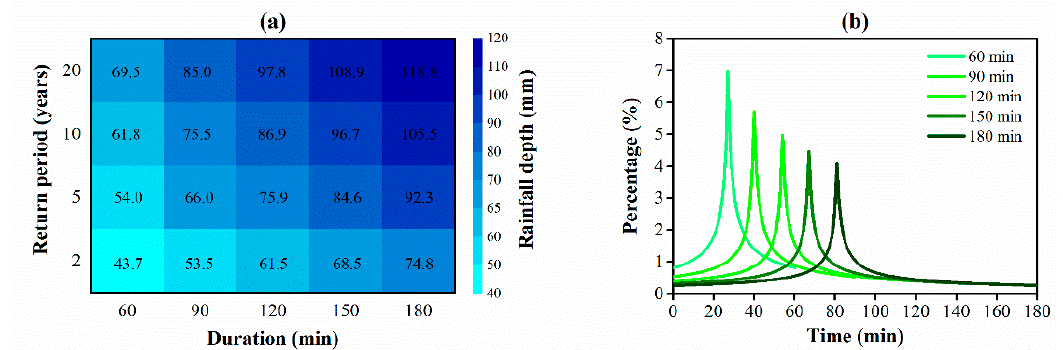
Figure 3. Representation of ( a ) total rainfall depth and ( b ) rainfall pattern distribution for the 20 design rainstorms used in the case study.